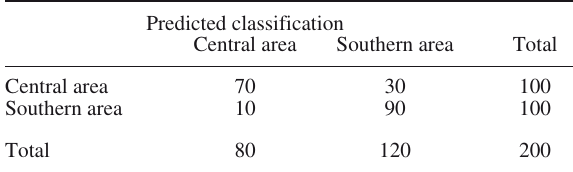
Table 3. – Classification matrix (%) of sagittal otoliths for Stran- gomera bentincki from central (n=30) and southern areas